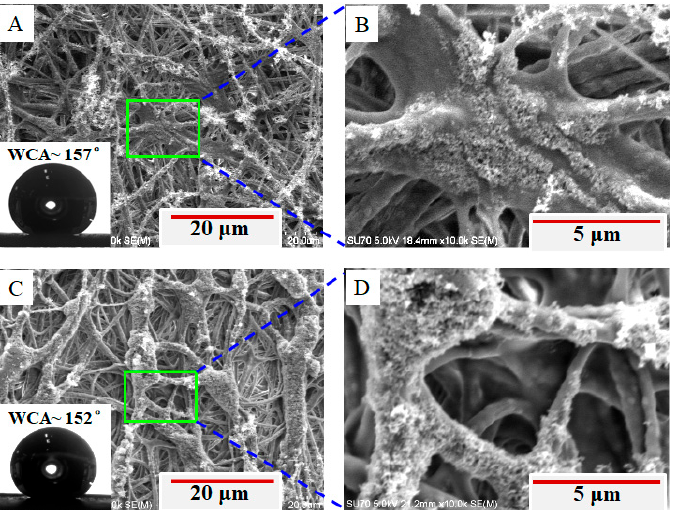
Figure 4. SEM images and WCA (inset) of as-electrospun fibrous membranes deposited on the heating substrate with the soot: ( A ) at the heating temperature of up to 80 °C and the enlarged image ( B ) of fibers as indicated in subfigure (A), and ( C ) at the heating temperature of up to 120 °C and enlarged image ( D ) of fibers as indicated in subfigure (C). The insets show WCAs of the corresponding